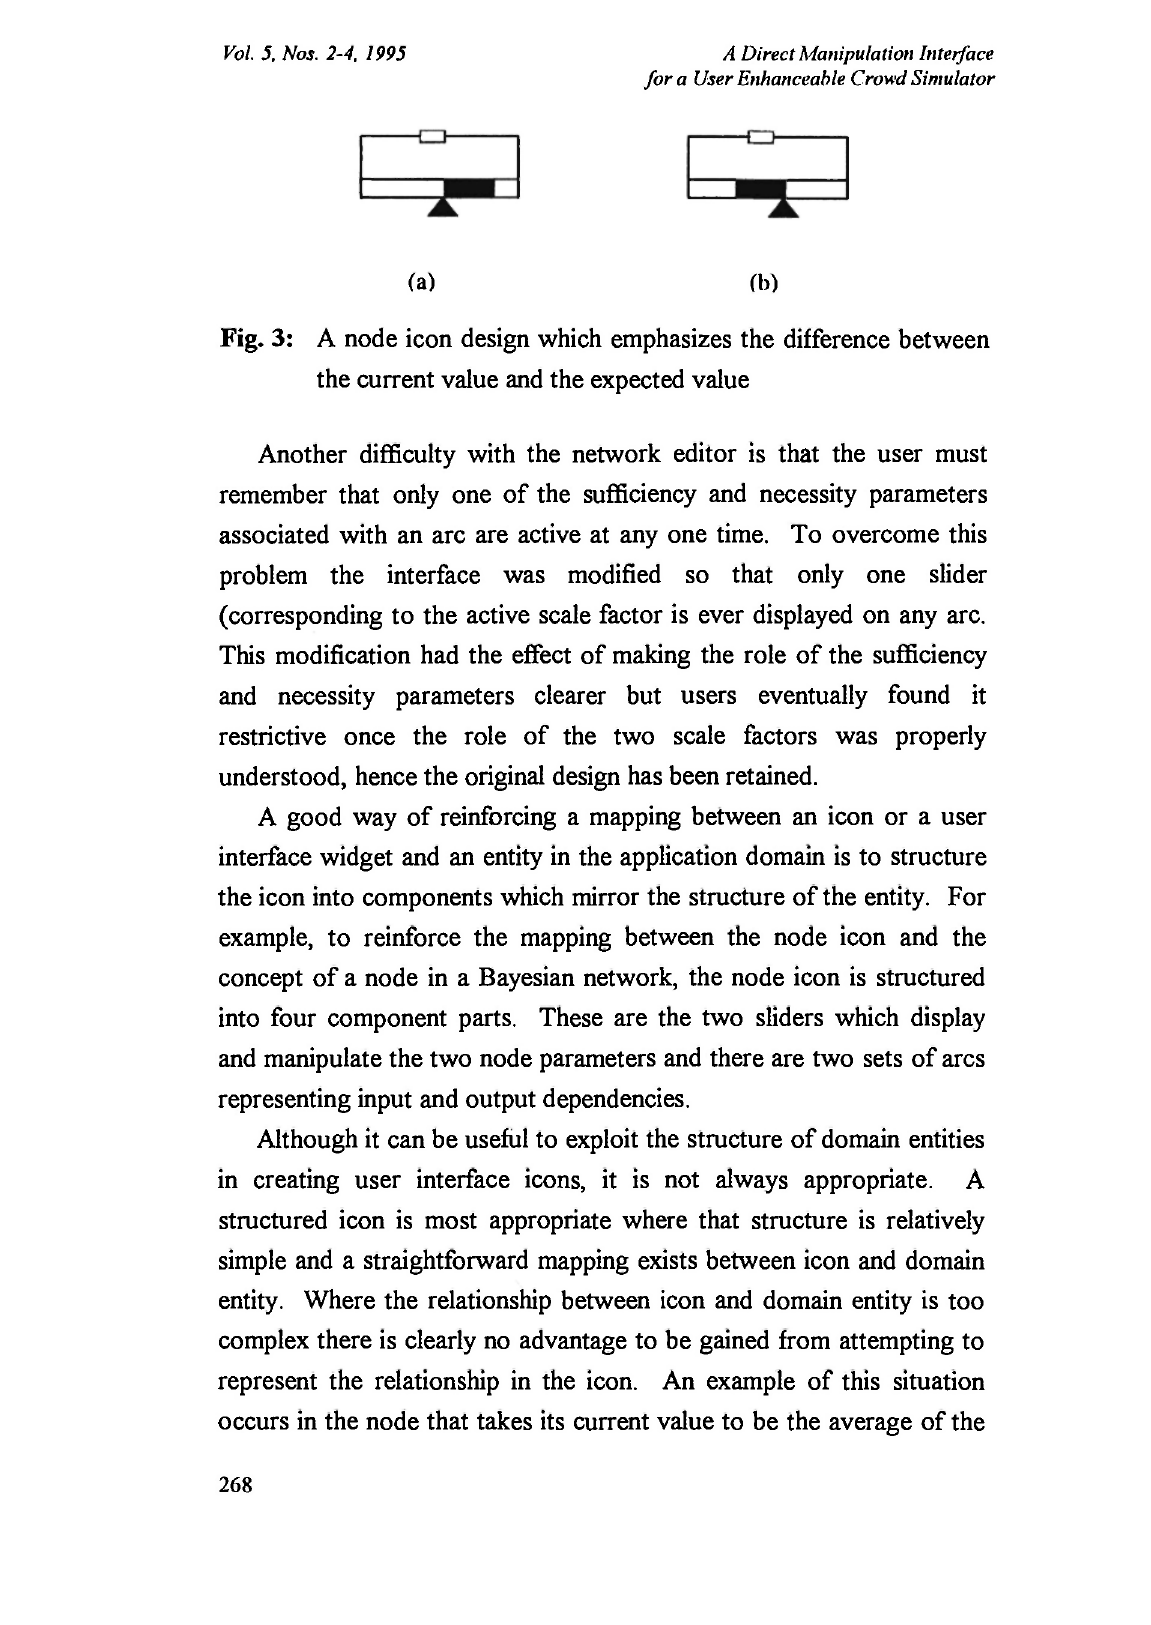
Fig. 3: A node icon design which emphasizes the difference between the current value and the expected